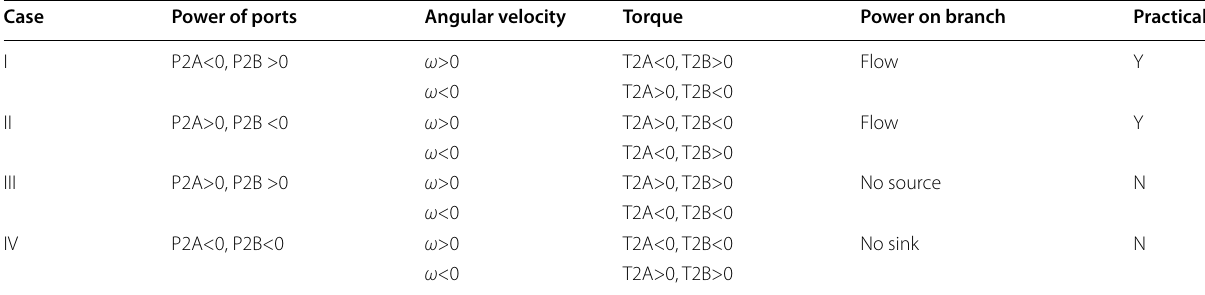
Table 1 Variation for directions of torque and power within power branch 2A‑2B Case Power of